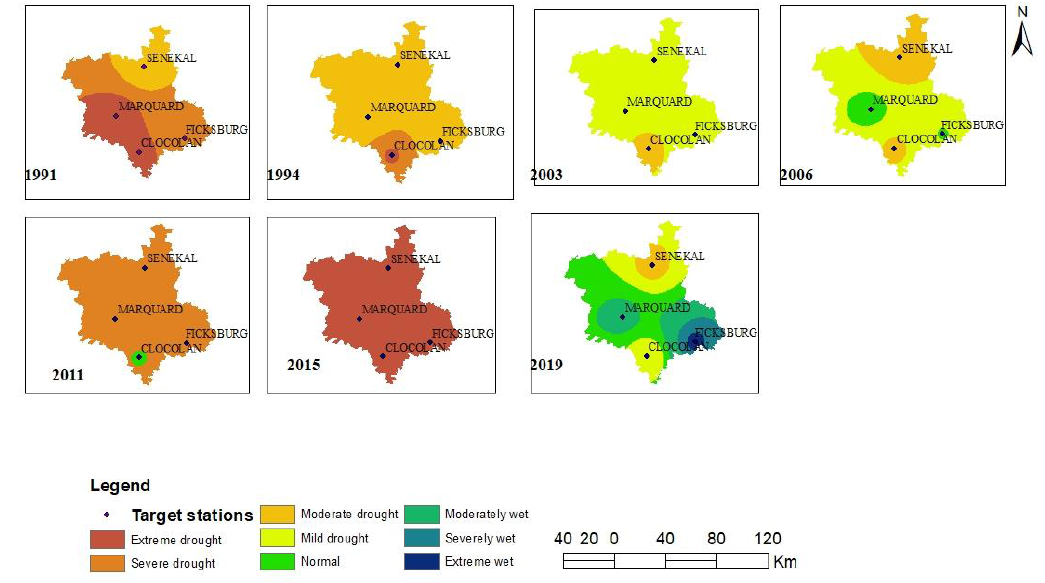
Figure 6. RDI-6 spatial-temporal pattern of drought in Setsoto municipality (1985–2019) based on RDI values.